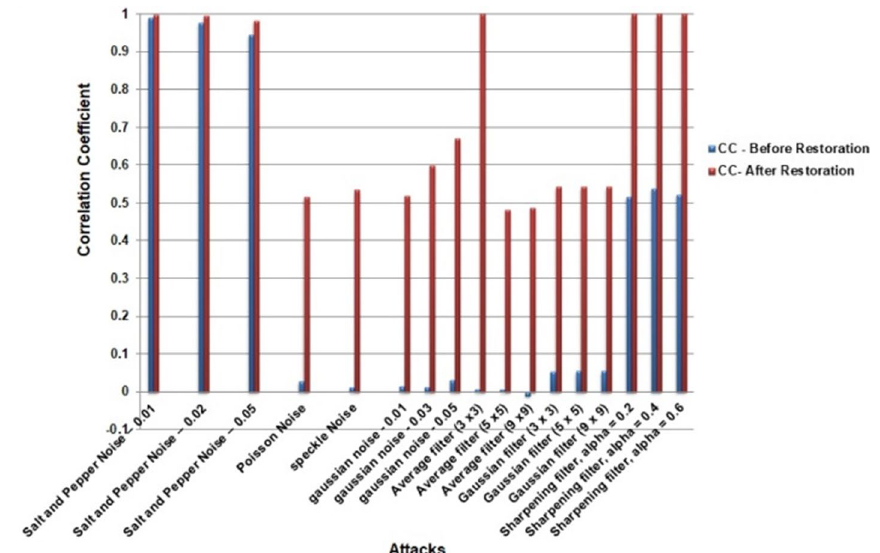
Fig. 9 Attacks vs. visual metrics—correlation coefficient